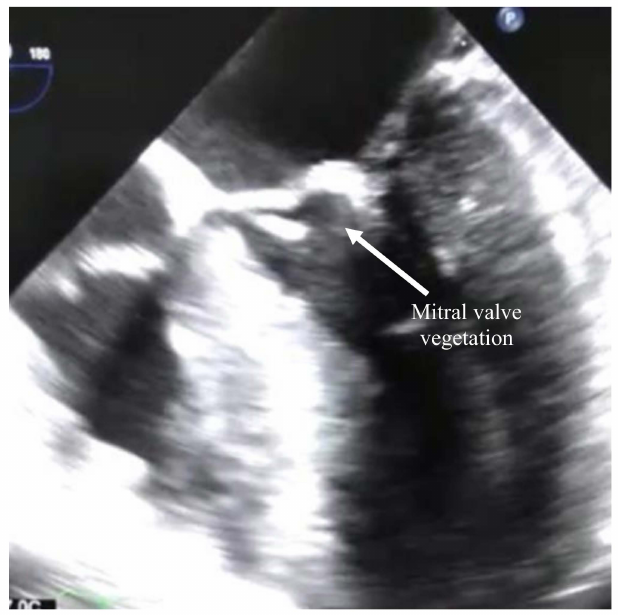
Figure 1. Echocardiography showing the mitral valve with a vegetation attached to the ventricular surface of the anterior leaflet